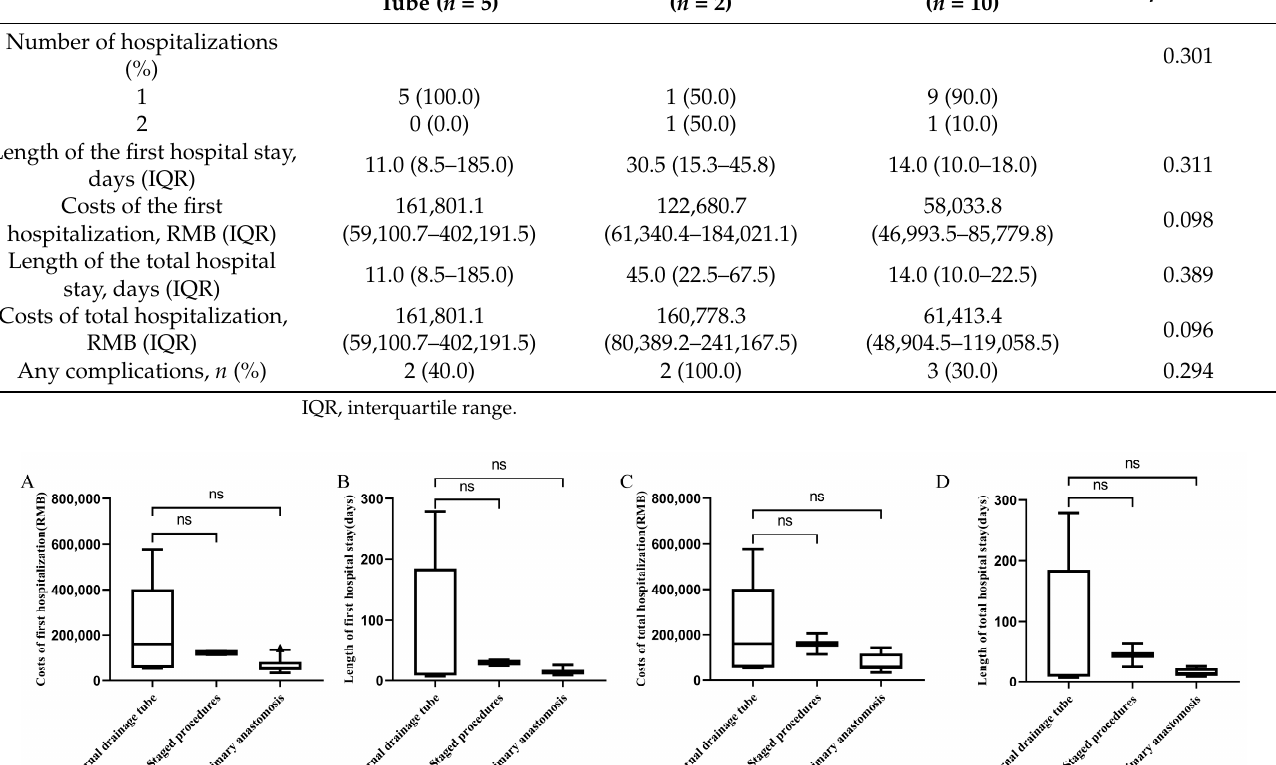
Table 2. Clinical outcomes of emergency patients.